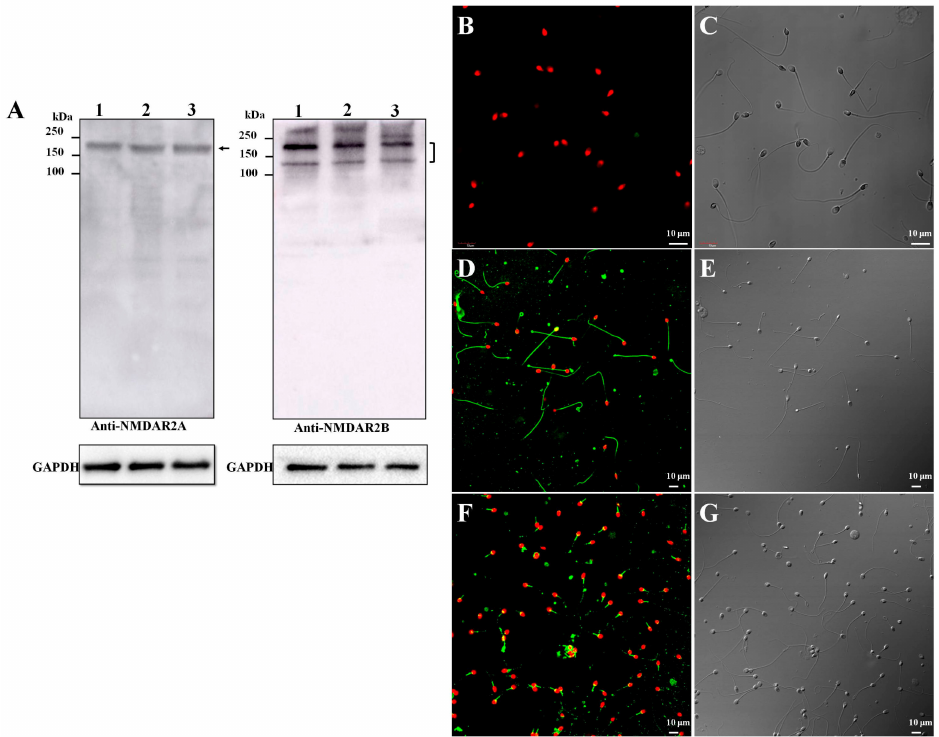
Figure 1. Expression of two NMDA receptor subunits, NMDAR2A and NMDAR2B, in human sperm. ( A ) The antibodies, Western blotting. GAPDH was blotted as the negative control. ( B , C ) Rabbit IgG was taken as the negative control. ( D ) Immunofluorescence staining and ( E ) bright-field microscopy of NMDAR2A. ( F ) Immunofluorescence staining and ( G ) bright-field microscopy of